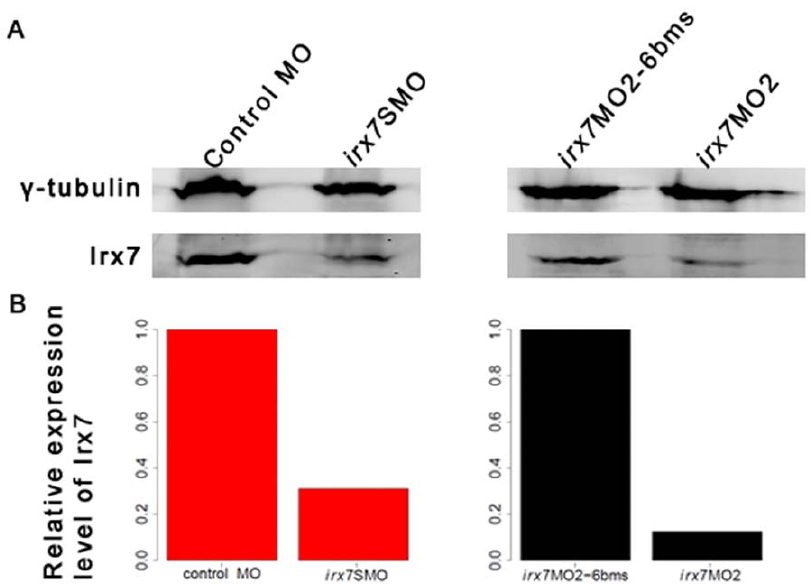
Figure 4. Microinjection of irx7 SMO (10 ng) and irx7 MO2 (3 ng) drastically reduces Irx7 protein level. The heads of 35 embryos injected with control MO and irx7 SMO, and 30 embryos injected with irx7 MO2-6 bms and irx7 MO2 were dissected at 72 hpf. Proteins were then extracted from these samples and Irx7 expression detected by Western blot using anti-Irx7-234 (A). C -tubulin was used as a loading control. The specificity of the Irx7 antibodies was first confirmed by Western blot using various recombinant Irx7 proteins of different lengths (Table S1 and File S3) expressed from bacterial culture (data not shown). Using the information extracted from the Western blot, the protein level of Irx7 was found to be reduced by 69.01% and 87.58% respectively in the dissected heads of irx7 SMO and irx7 MO2 morphants when compared to the corresponding controls